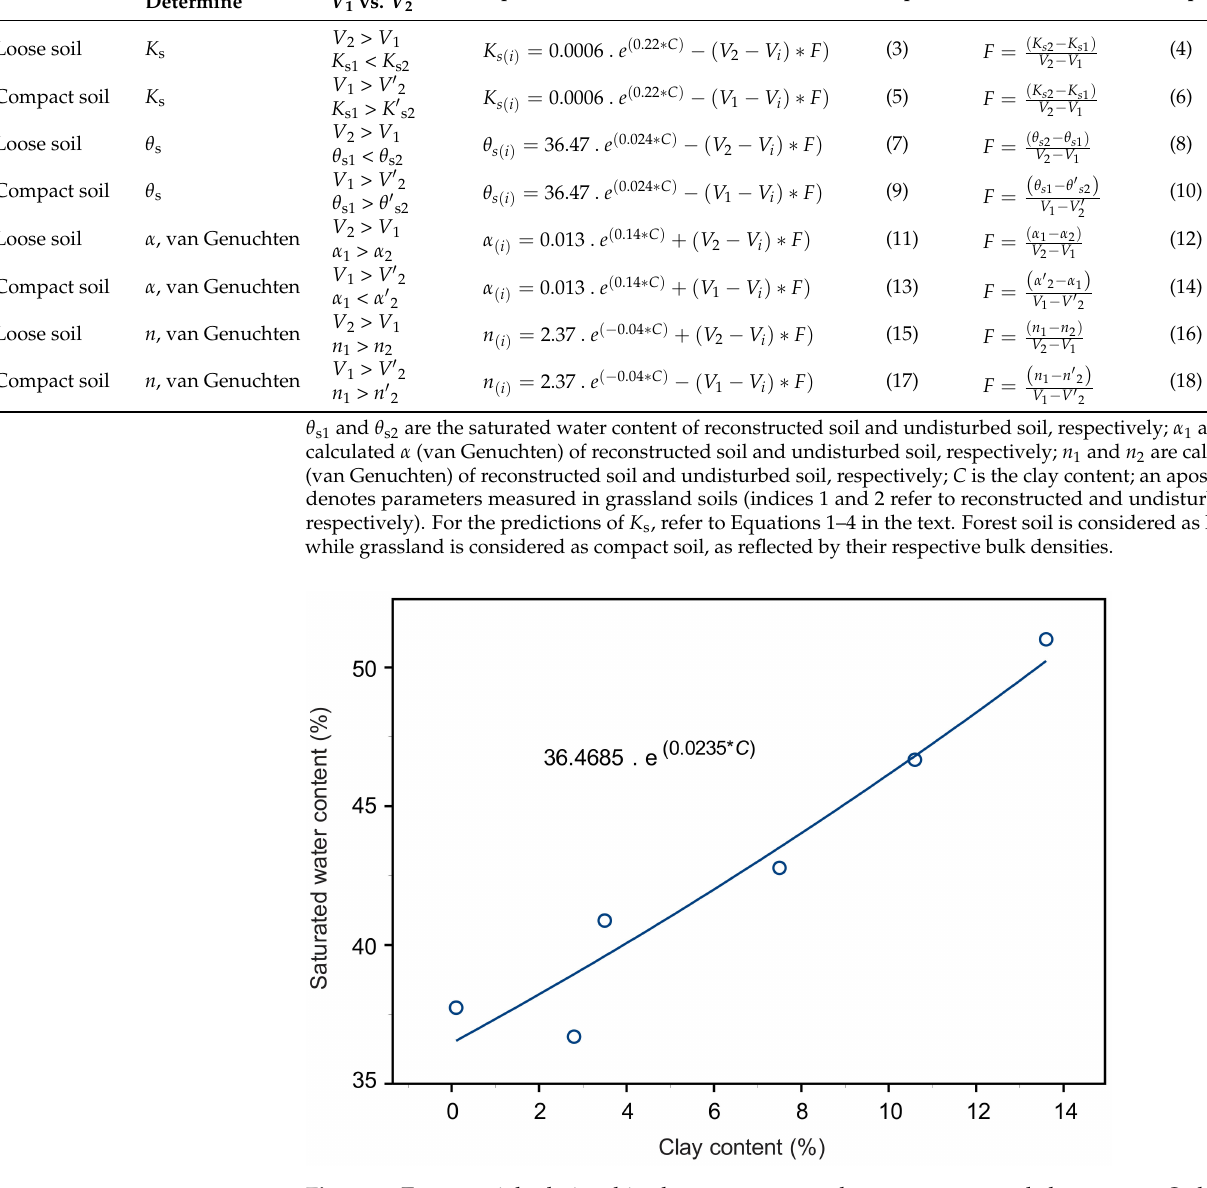
Figure 3. Exponential relationships between saturated water content and clay content C ; data from six reconstructed soil